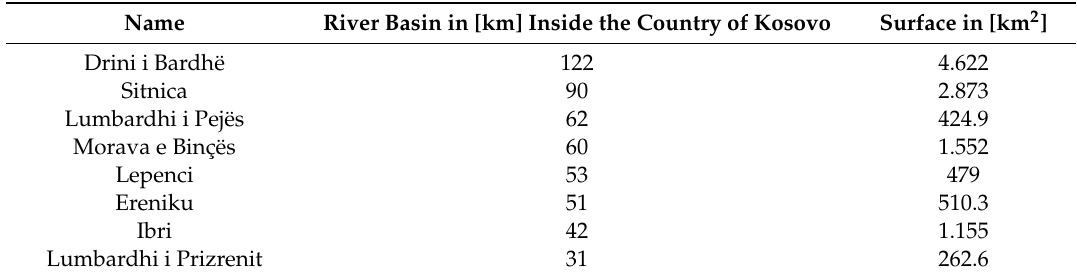
Table 3. Distance in km and the surface of main River Basins of Kosovo [21].